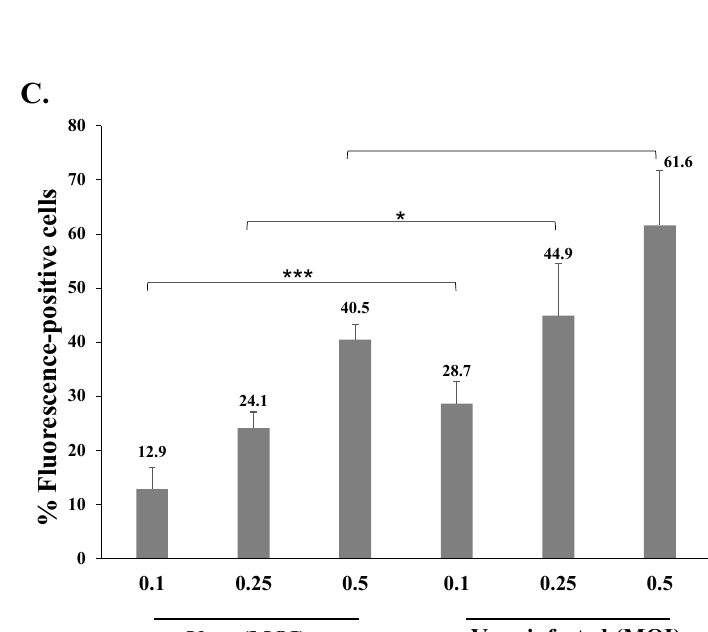
Figure 4. KSHV-infected Vero cells can be superinfected and display enhanced expression of the fluorescent marker of the incoming virions. ( A ) Naive Vero cells and latently infected Vero cells that carry ( A ) BAC16-mCherry or ( B ) BAC16- mNeonGreen were infected as described in Figure 2, and the percentages of cells expressing mNeonGreen and mCherry were measured by FACS. ( C ) Percentage of cells expressing the fluorescent protein (mNeonGreen/mCherry) encoded by the incoming viral genome. Vero—naive uninfected cells, Vero-infected-latently Vero-infected cells that were re-infected. Results are based on an average obtained from three independent experiments. Statistical analysis was carried out using Tukey’s post hoc analysis test. *** p < 0.001, * p < 0.05. Naive uninfected Vero cells were used as a negative control, while